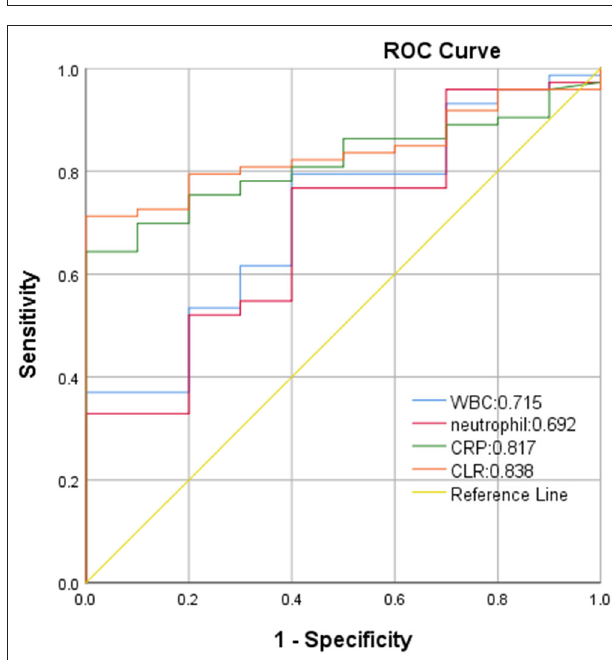
FIGURE 4 | ROC curve of CLR in predicting poor outcome of patients with aSAH in severe group (Hunt-Hess of > 3).